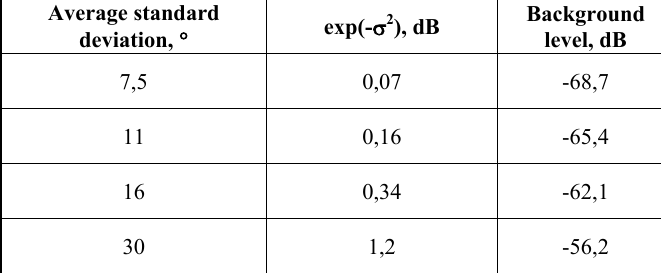
Table 2. Radiation pattern parameters of